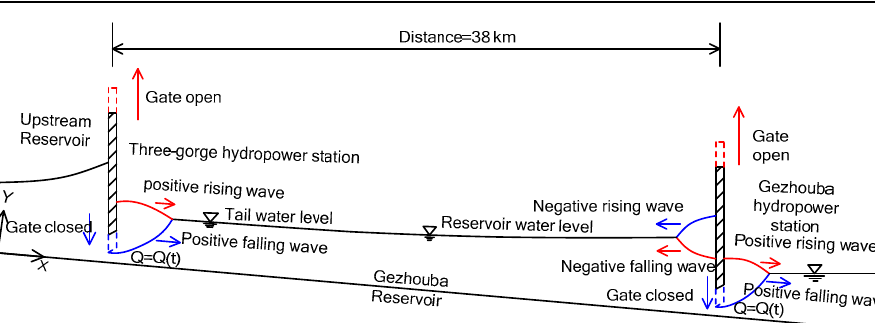
Figure 11. Water level variation process concerning locations of hydropower stations. ( a ) Lower lock head of the ship lift; ( b ) Approach channel entrance.